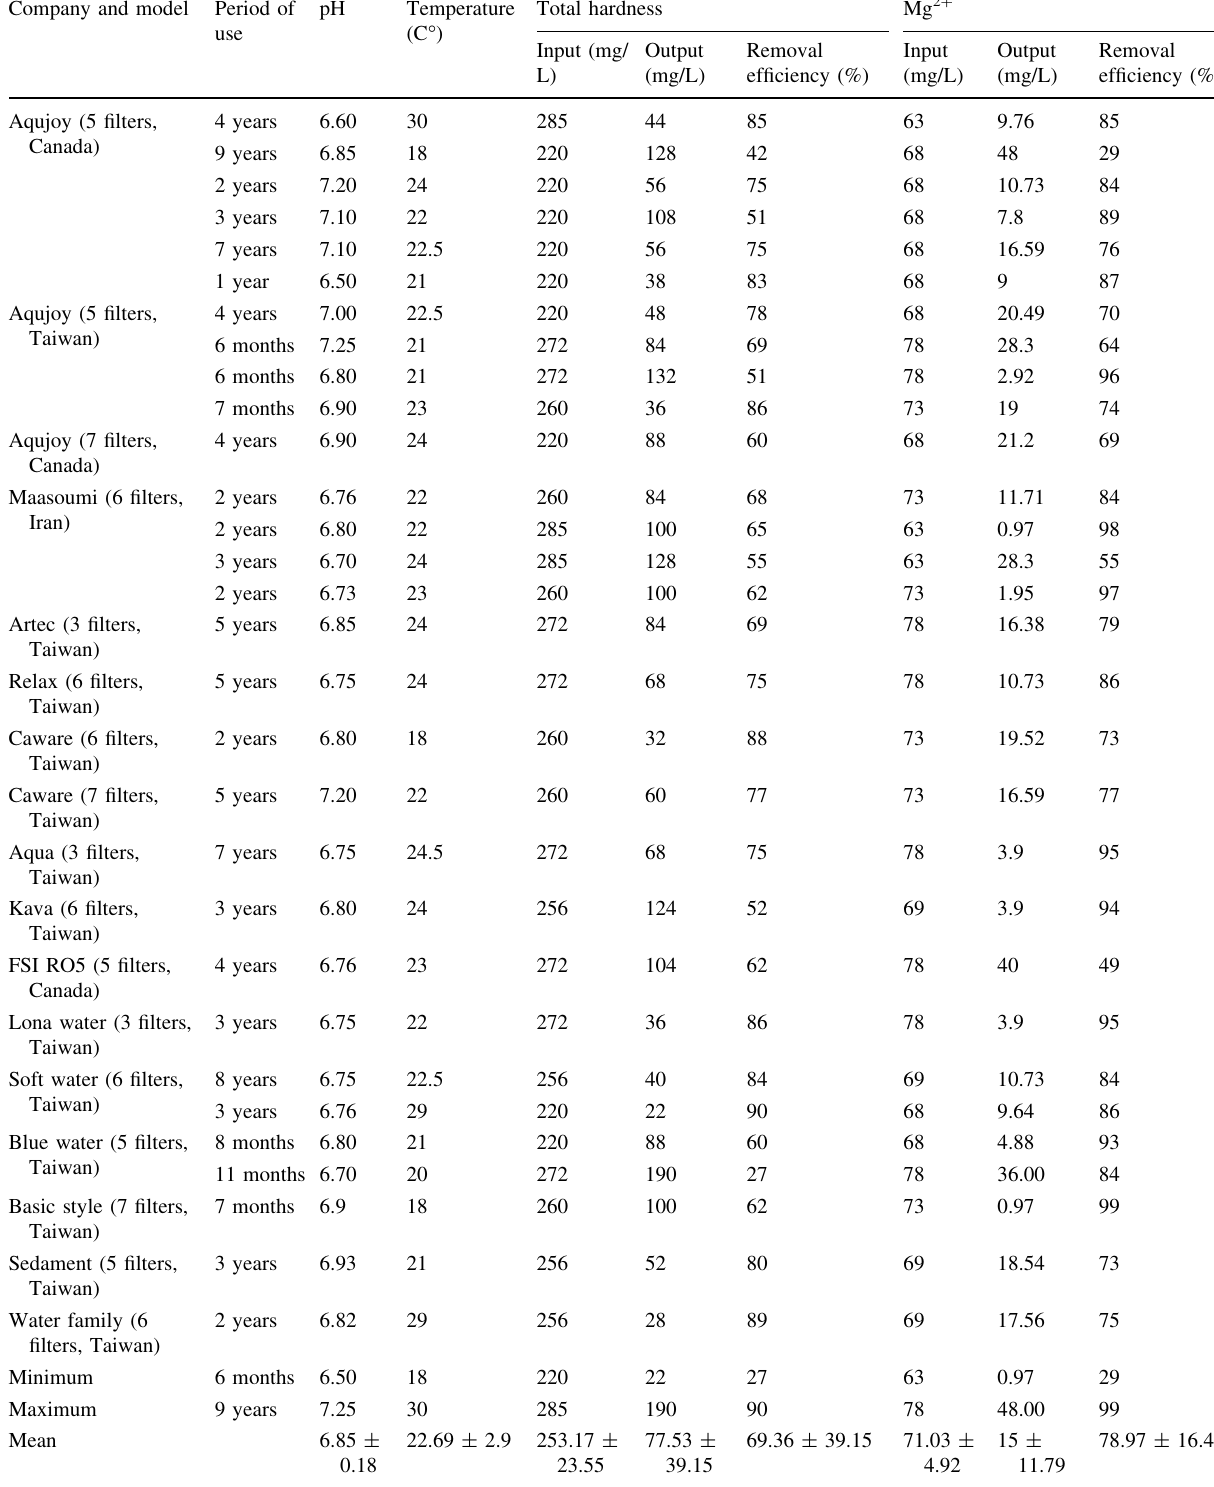
Table 2 Specifications of household water treatment systems supplied in Kerman and efficacy of these devices in the removal of cations Na ? , Ca 2 ? , Mg 2 ? , and total hardness of drinking water in Kerman in 2016 Company and model